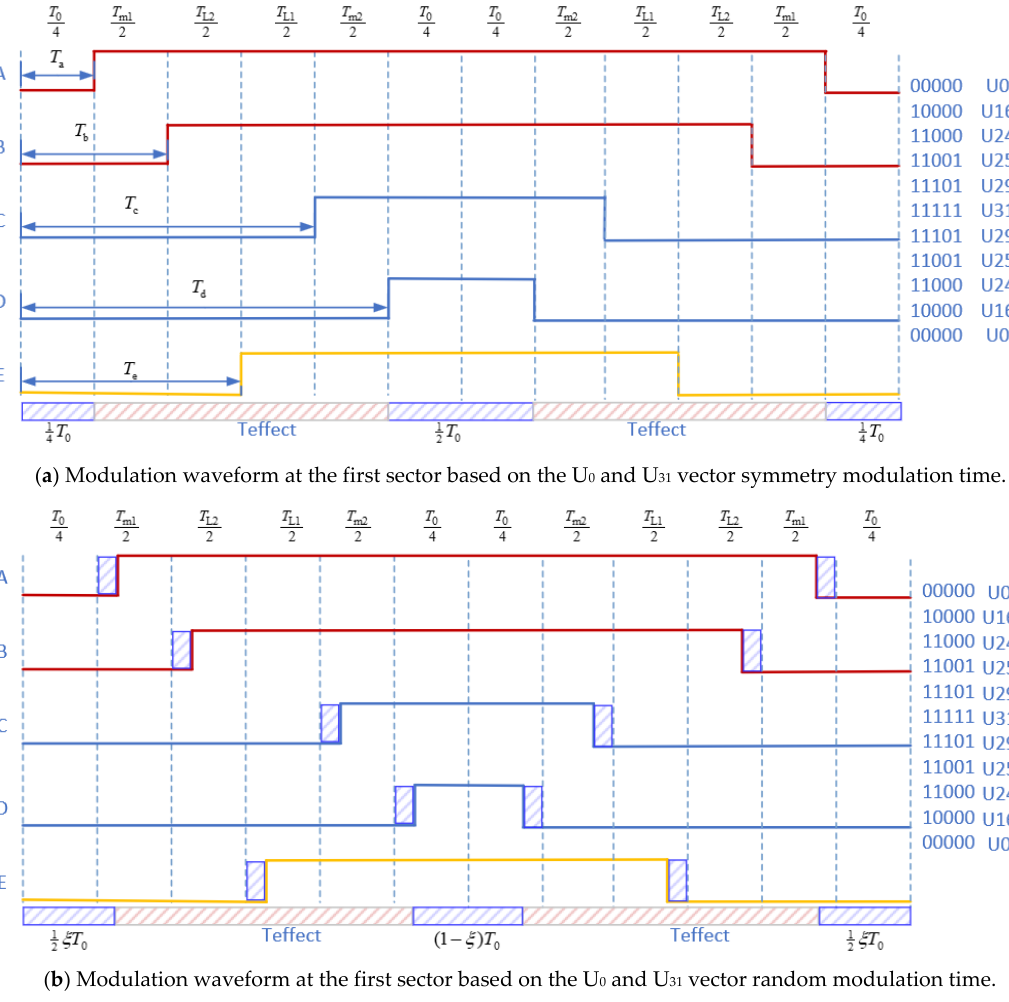
Figure 8. Random modulation waveforms of the first sector of a five-phase induction motor.